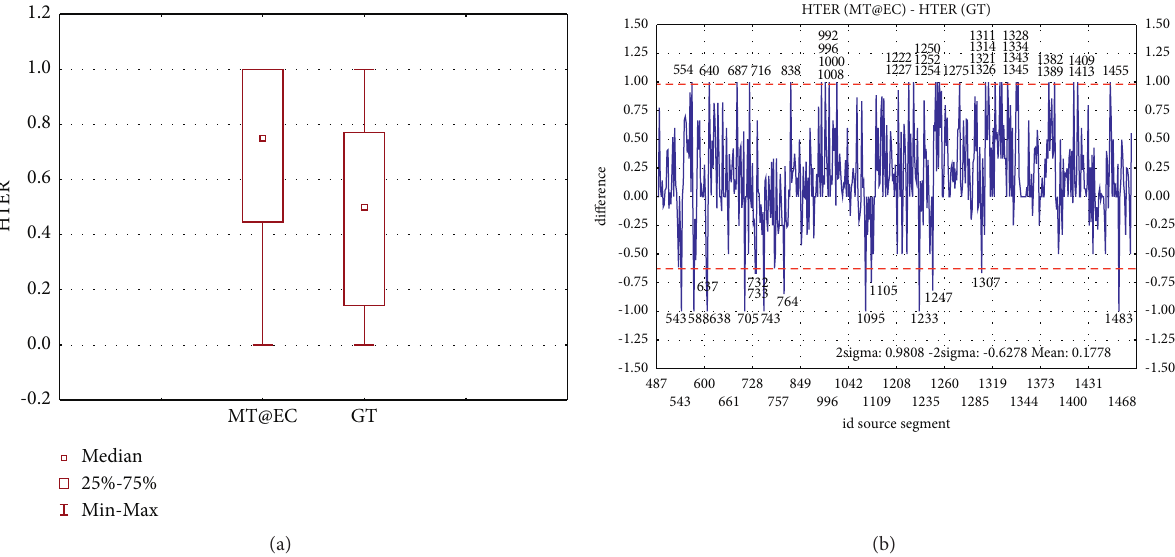
Figure 5: Visualization of descriptive statistics for semiautomatic MT evaluation: HTER metric (a) and residuals for MT output (b).